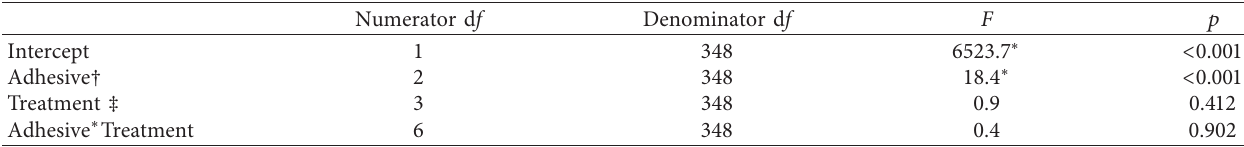
Table 3: Linear mixed-effects model to determine the effect of adhesive and treatment on microtensile strength.